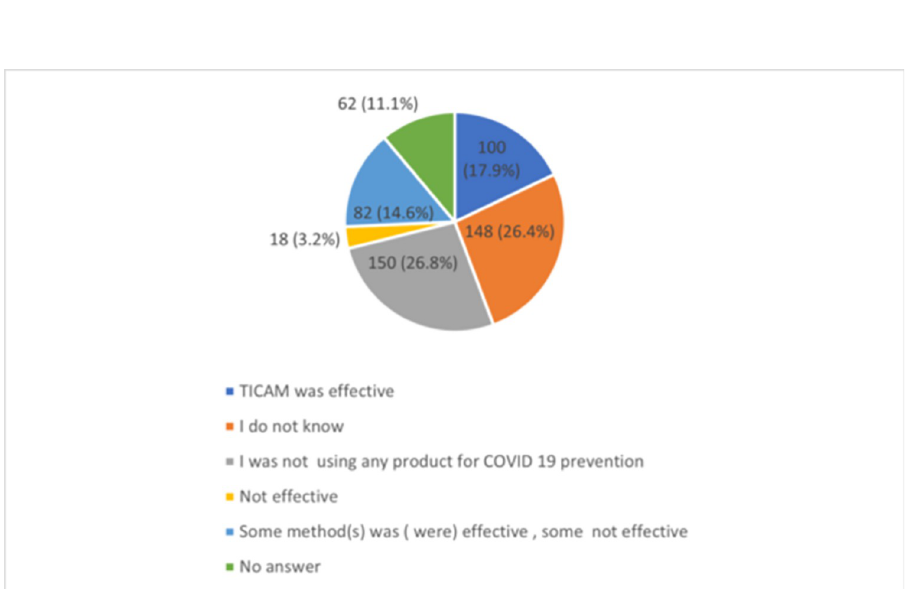
Fig 4. Participants’ opinion regarding T&CM